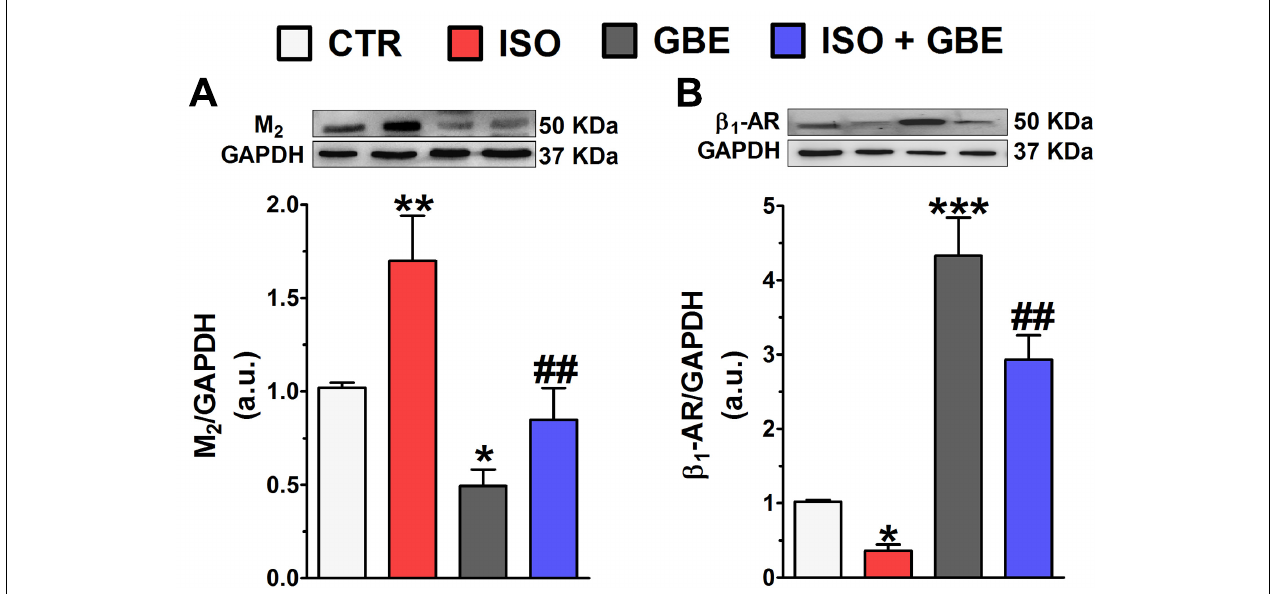
FIGURE 2 | Ginkgo biloba extract modulates cardiac muscarinic receptor (M 2 ) and β -adrenergic receptors ( β 1 -AR) in hypertrophied hearts. ( A,B , top) Representative western blot and quantitative analysis of M 2 (A) and β 1 -AR (B) protein levels. Data are represented as means ± SEM, ( n = 3–6). ∗ p < 0.05, ∗∗ p < 0.01, and ∗∗∗ p < 0.001 vs. CTR, ## p < 0.01 vs. ISO, one-way ANOVA followed by Bonferroni’s